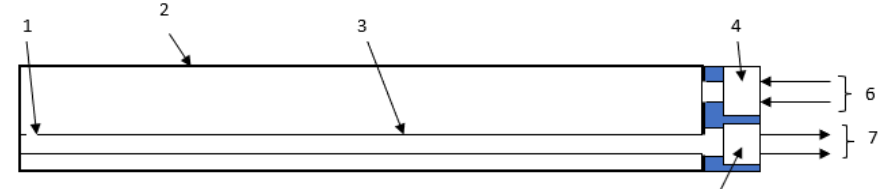
Figure 3. The sketch of the measuring part of the acoustic temperature transducer. 1 — the open end of the inner tube, 2 — the outer tube, 3 — the inner tube, 4 — the acoustic transmitter, 5 — the acoustic